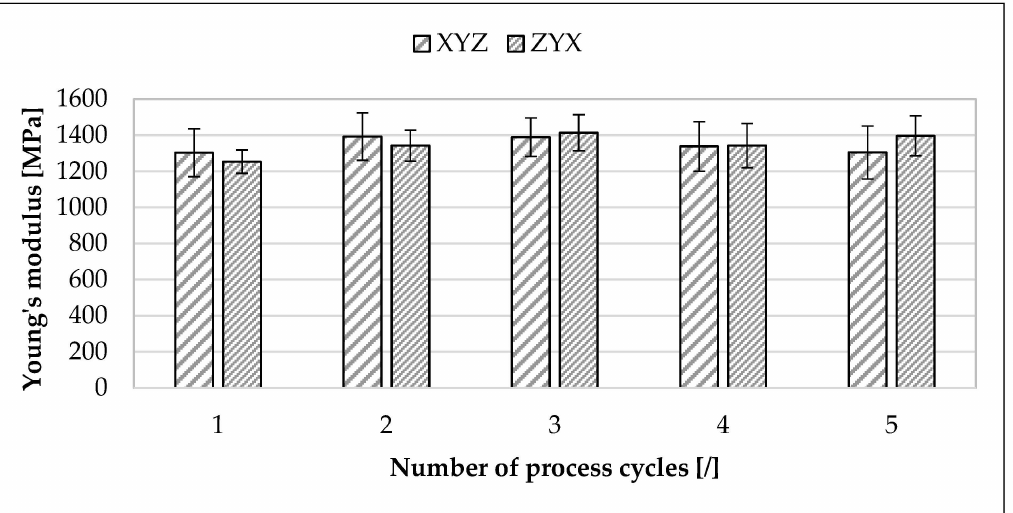
Figure 11. Influence of cyclic reuse on Young’s modulus of the specimens manufactured from the used polyamide 12 sinter material. Five process cycles were considered. YXZ- and ZYX-specimens were analyzed. The refresh rate was 30